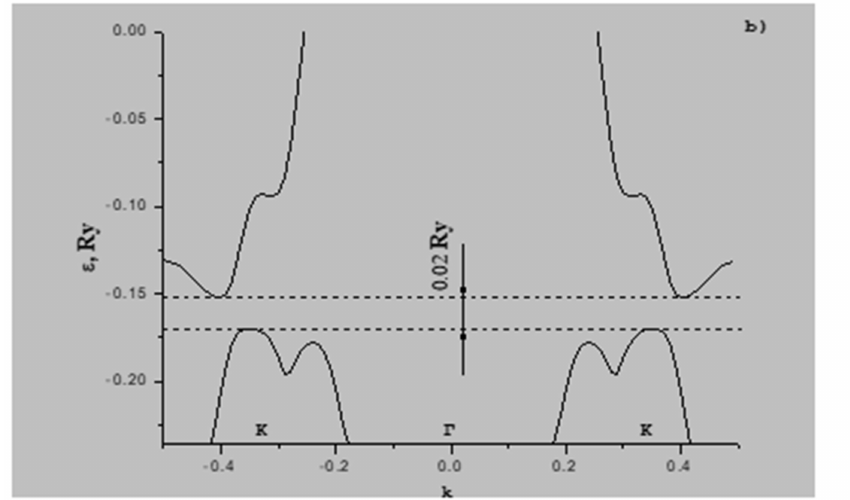
Figure 1. ( a , b ) Dependency for electron energy ε at the wave vector k in the graphene containing potassium